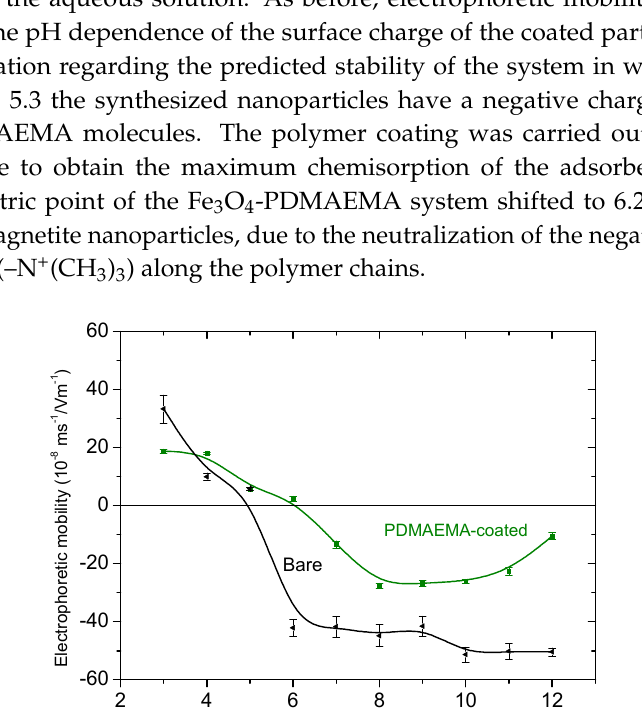
Figure 6. Electrophoretic mobility vs. pH for magnetite immediately after phase transfer to water, and after 15 days stored at room temperature in aqueous medium.